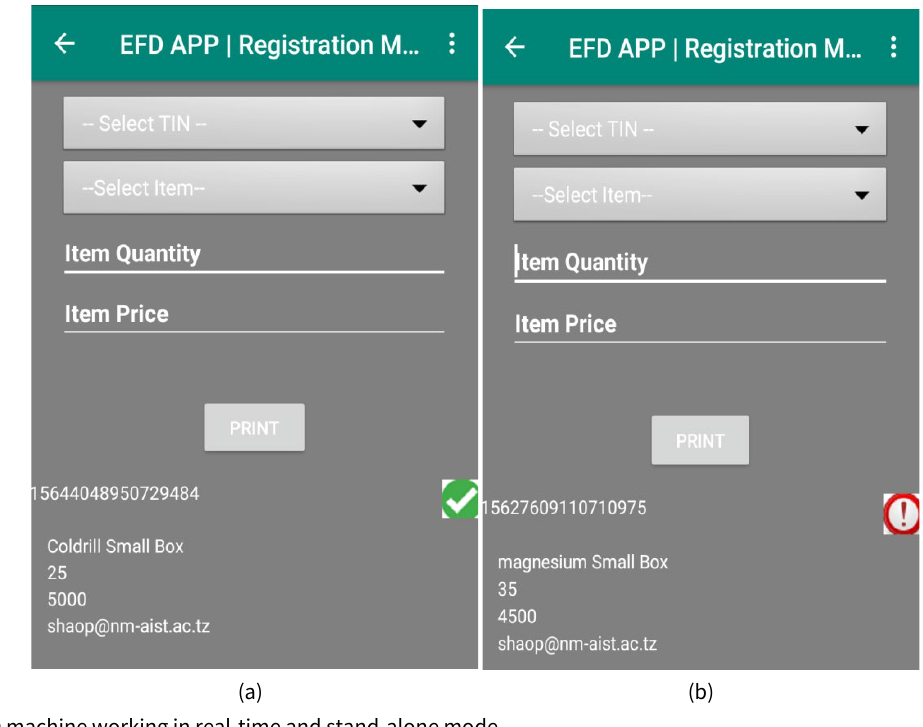
Figure 6. EFD machine working in real-time and stand-alone